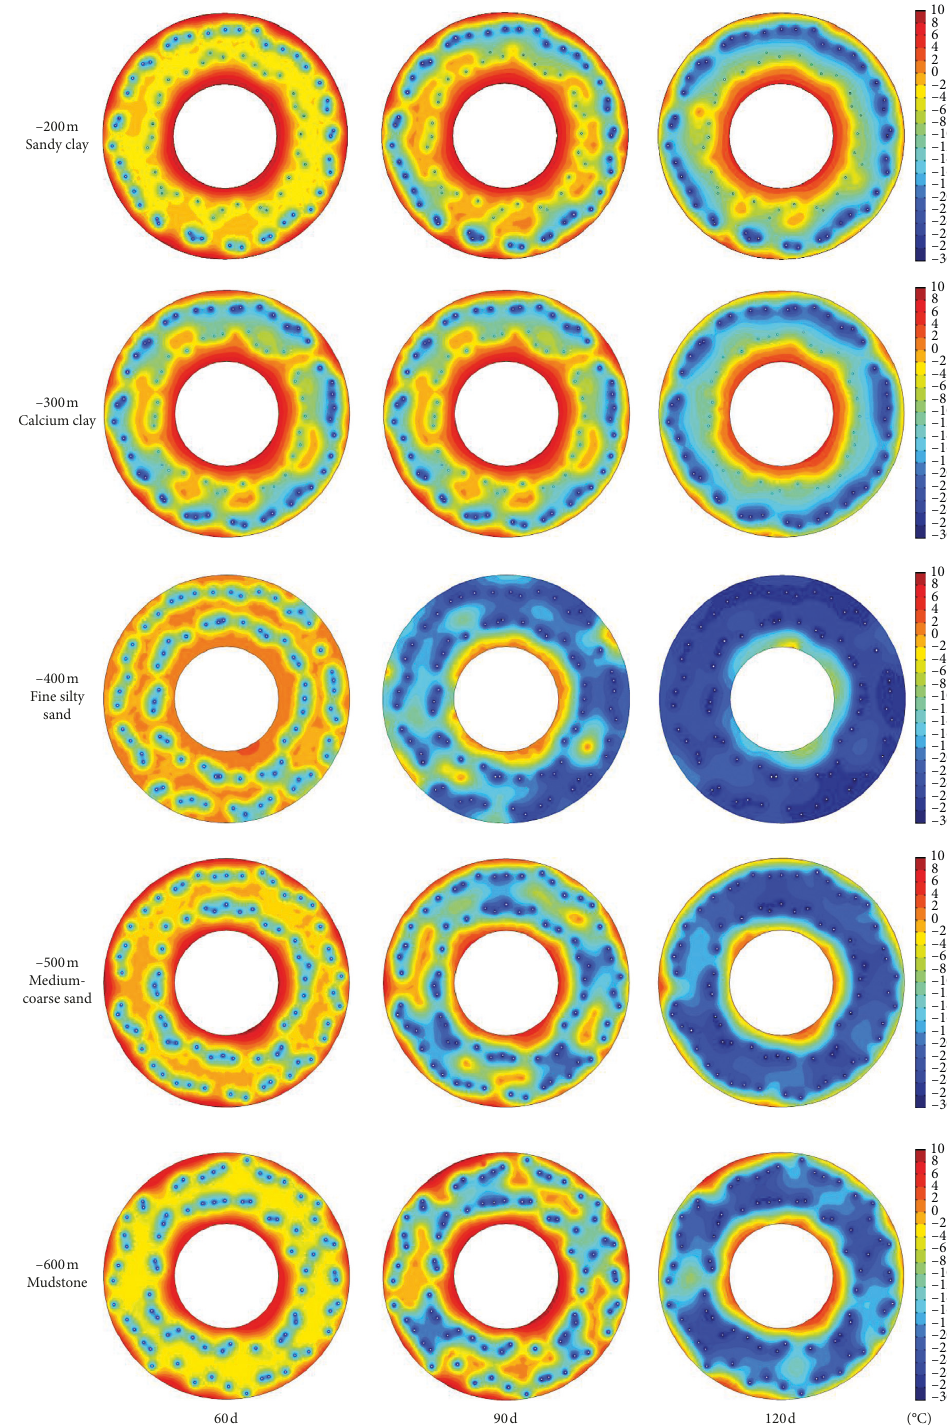
Figure 12: Development law of the freezing temperature field in different